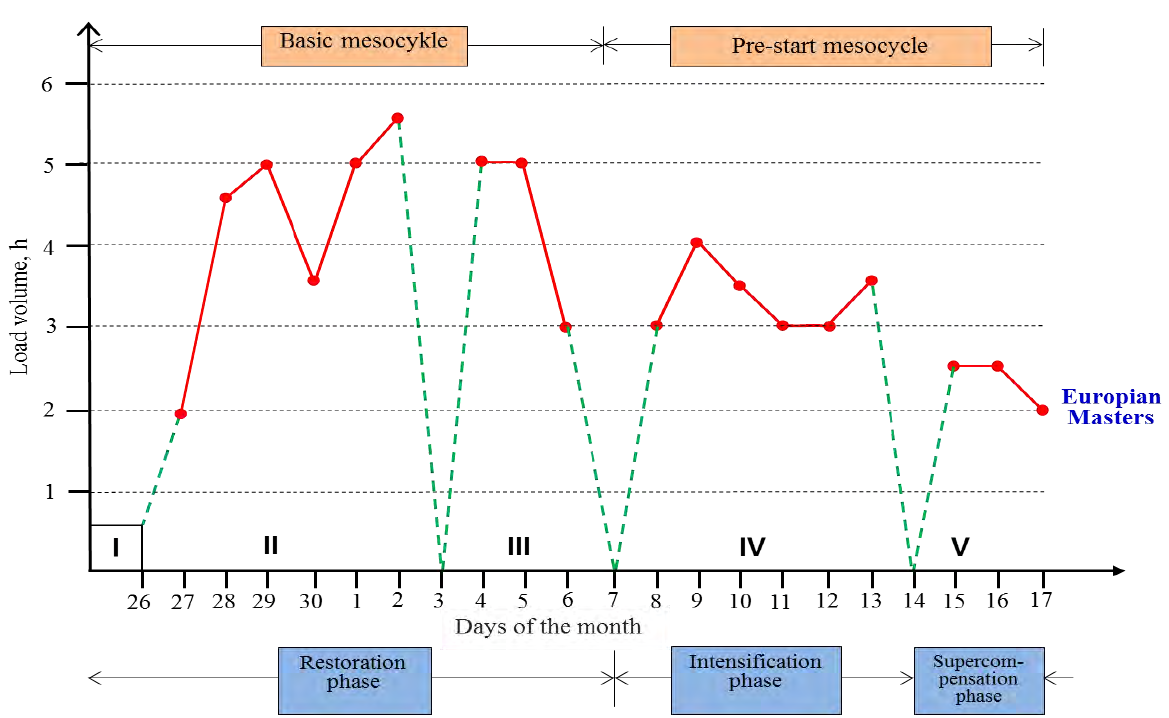
Fig. 1. M.L.’s direct preparation for the Girls’ Tennis Europe Junior Masters, 2002.